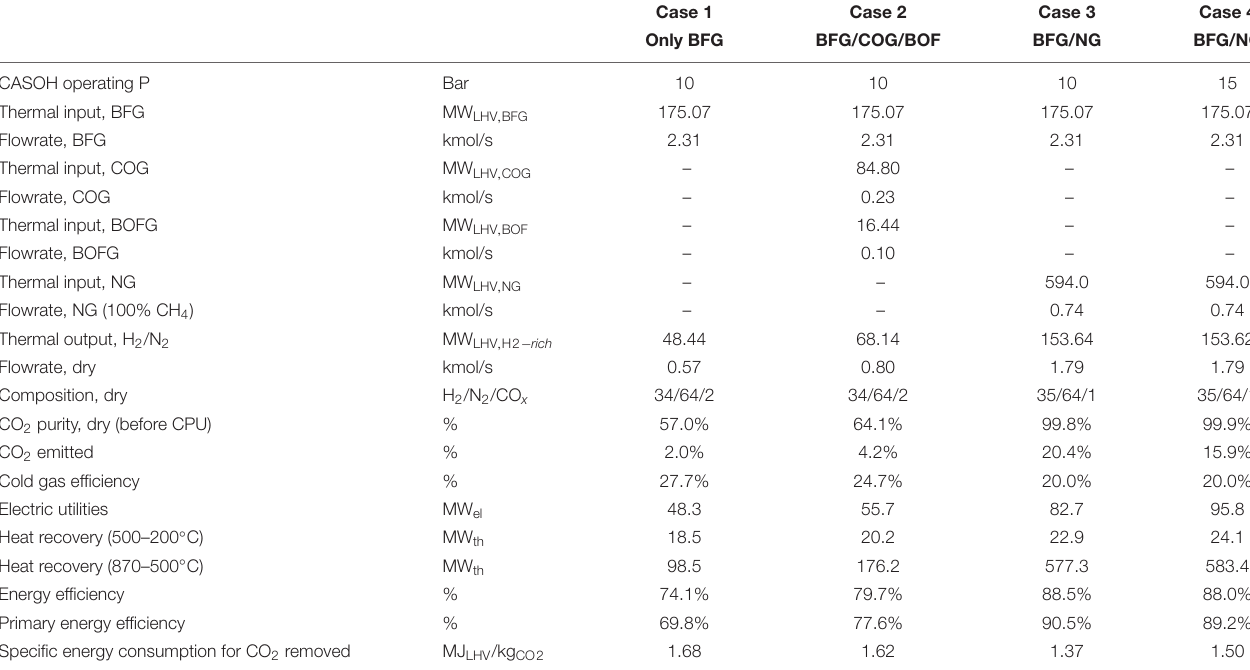
TABLE 4 | Main performance results of different configurations of the Ca-Cu process fueled with steel mill